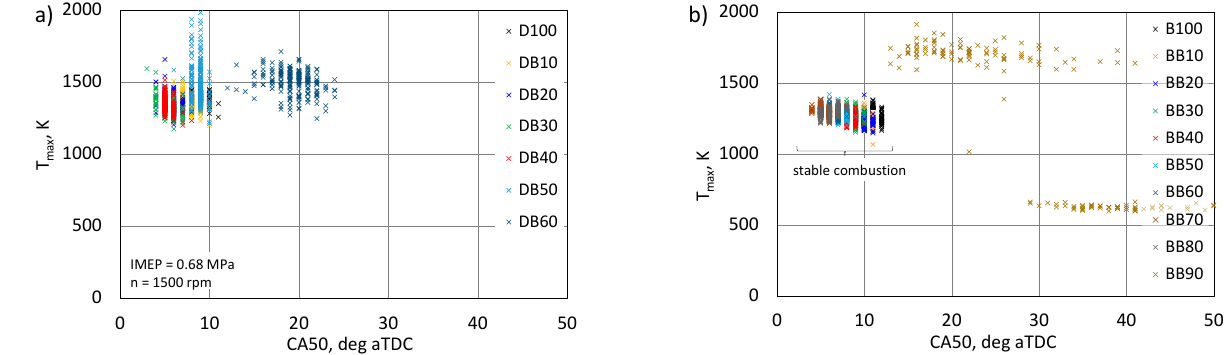
Figure 13. Relationship of maximum temperature and CA50 for DB ( a ) and BB ( b ).